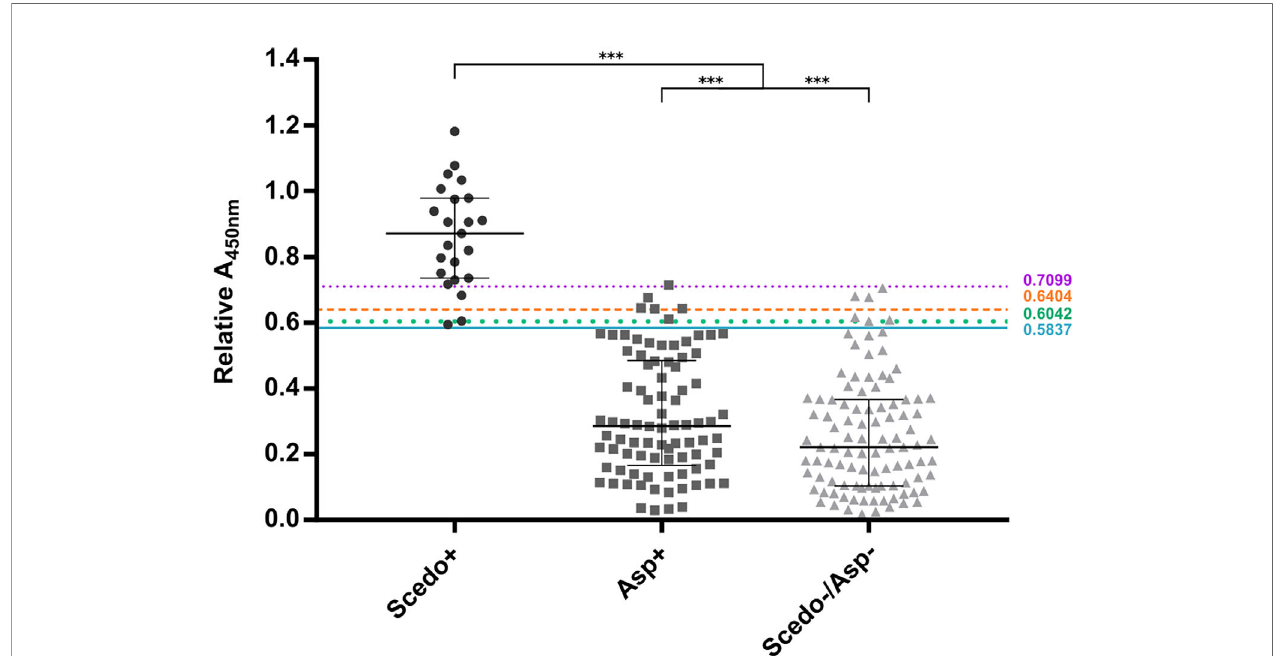
FIGURE 6 | IgG response against Scedosporium boydii Total WCP extract of cystic fi brosis patients. Patients with positive sputum cultures for Scedosporium/ Lomentospora are classi fi ed into group Scedo+, with positive cultures for Aspergillus spp. into group Asp+, and cultures without any recovery of these fungi into group Scedo-/Asp-. Antibody responses are represented by the relative Abs value at 450 nm obtained for each serum. The four cut-off values obtained are depicted as solid, dotted and dashed lines. Wide horizontal lines depict the median, and short horizontal lines represent the interquartile range (IQR). Median value obtained for group Scedo+ is signi fi cantly different from that obtained for each of the other two groups, and for the sum of both (as negative samples) (*** p < 0.001).